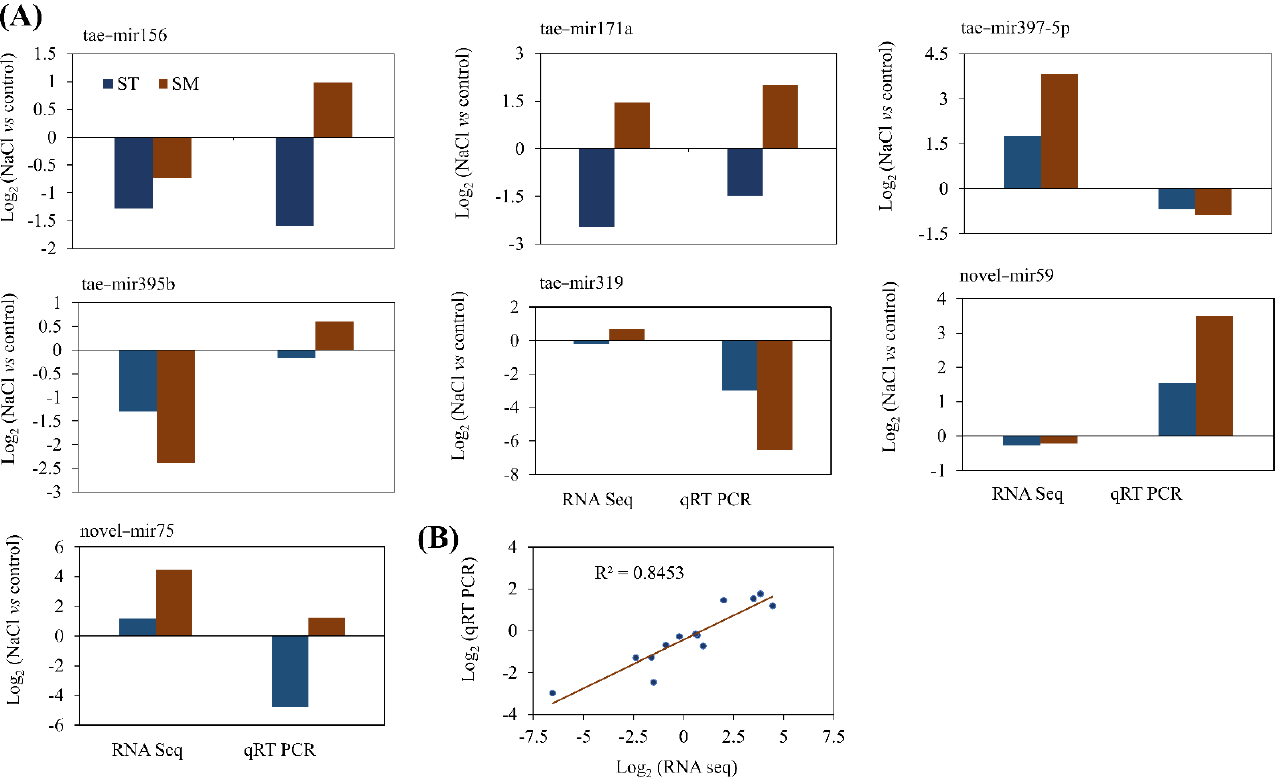
Figure 6. qRT-PCR confirmation of seven miRNAs identified in Suntop and Sunmate whose expression changed in response to salinity stress. ( A ) Expression patterns of seven miRNAs in the qRT-PCR and sequencing dataset. ( B ) Regression analysis of the RNA-Seq log 2 value and real time PCR values.